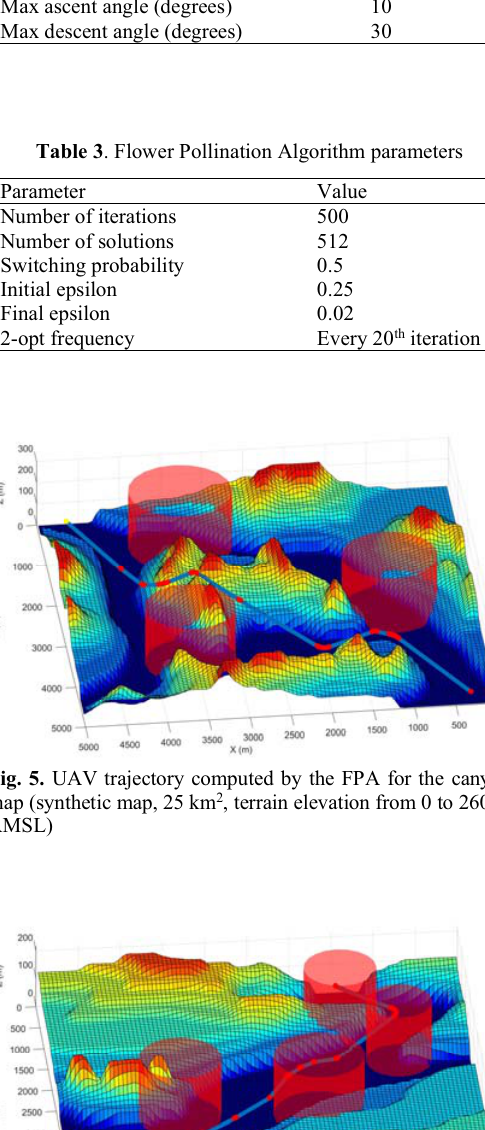
Table 1 . Specifications of the Silver Fox-like UAV [18]